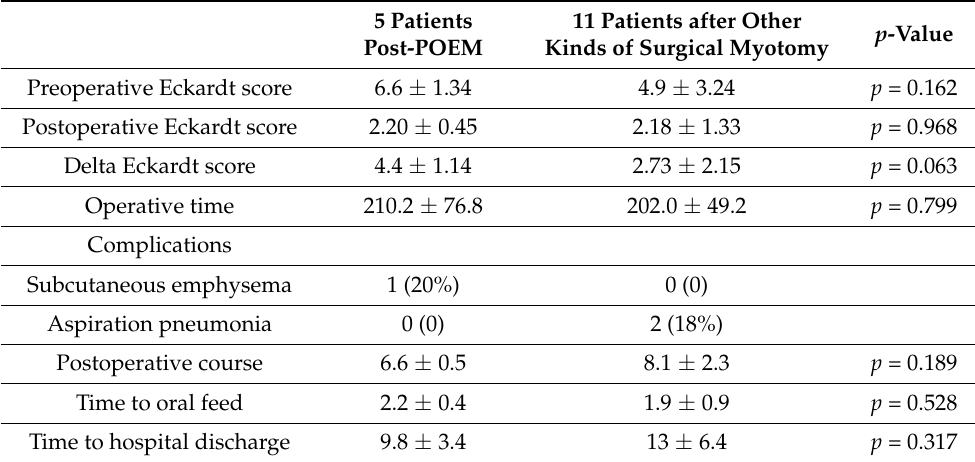
Table 3. Comparison of patients receiving POEM and other surgical